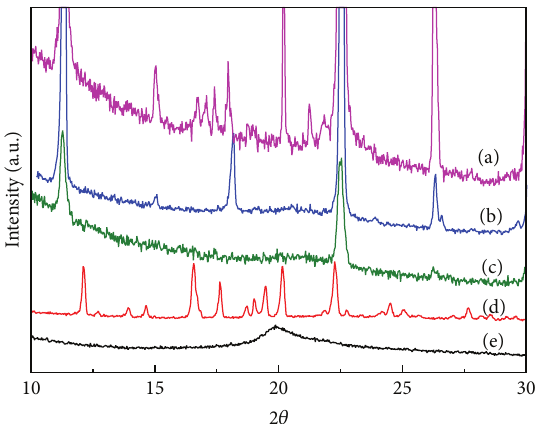
Figure 4: XRD pattern of chitosan hydrogel with different concen- trations of ibuprofen. Chitosan with 1.0% ibuprofen (a); chitosan with0.6%ibuprofen(b);chitosanwith0.2%ibuprofen(c);ibuprofen (d); and chitosan (e).